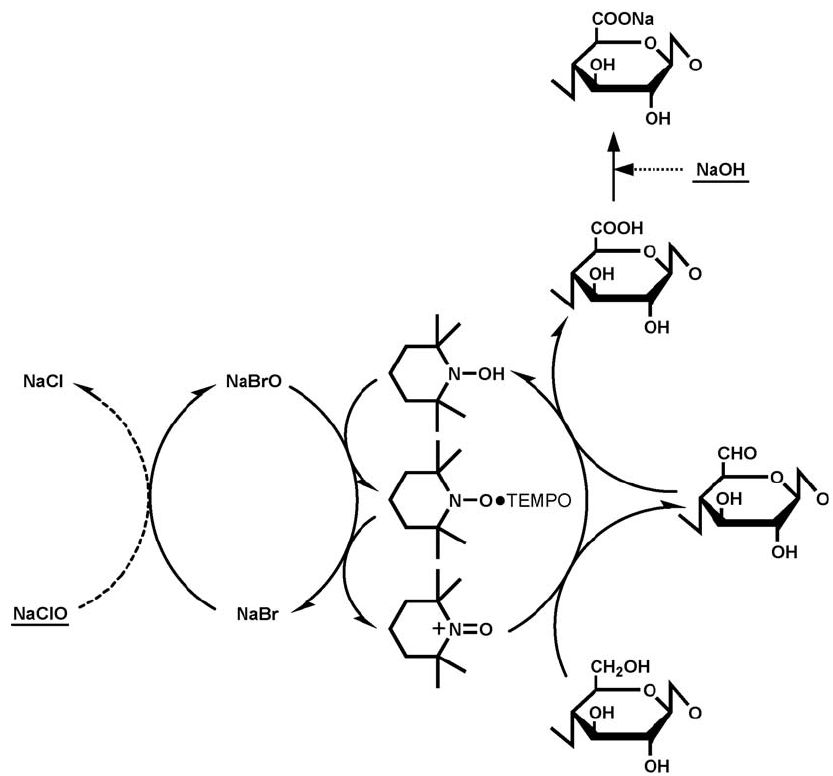
Figure 5. Schematic representation of the regioselective oxidation of cellulose by 2,2,6,6 tetramethyl-1-piperidinyloxy (TEMPO)